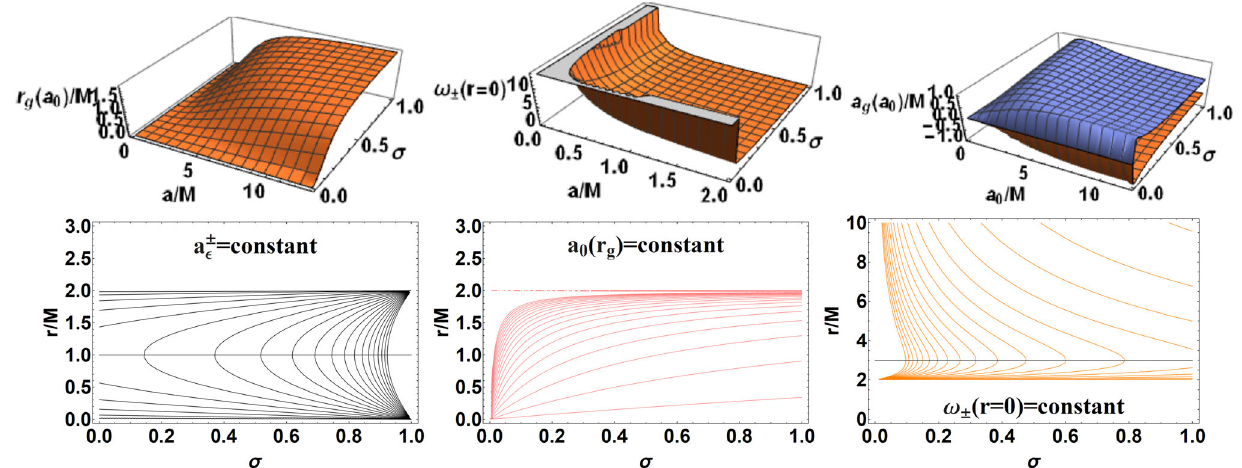
Fig. 1 Upperpanels:3Dplotsofthebundletangentradius r g ( a 0 )/ M as functionof a / M and σ ∈ [ 0 , 1 ] (left),theoriginfrequencies(singularity frequencies) ω ± =constant for r = 0 as function of ( a / M ,σ) (center), the tangent spin a g ( a 0 )/ M ∈ [ 0 , 1 ] as function of ( a / M ,σ) (right). Below panels. Left panel: ergosurface a ± (cid:9) = constant of Eq. (122) in